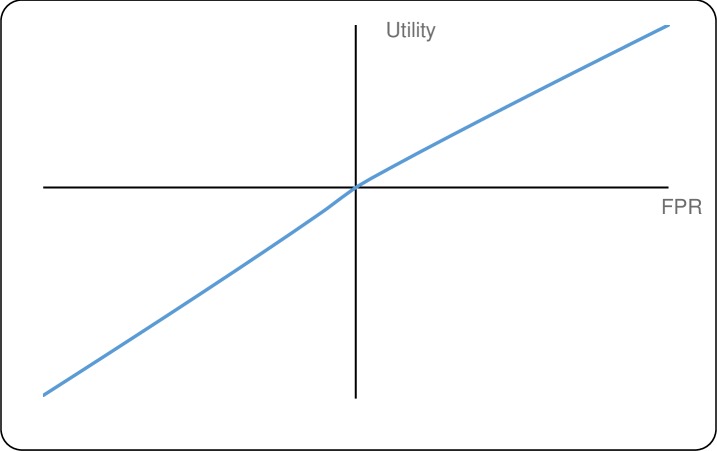
Plot of median utility (gains and losses) for FPR.